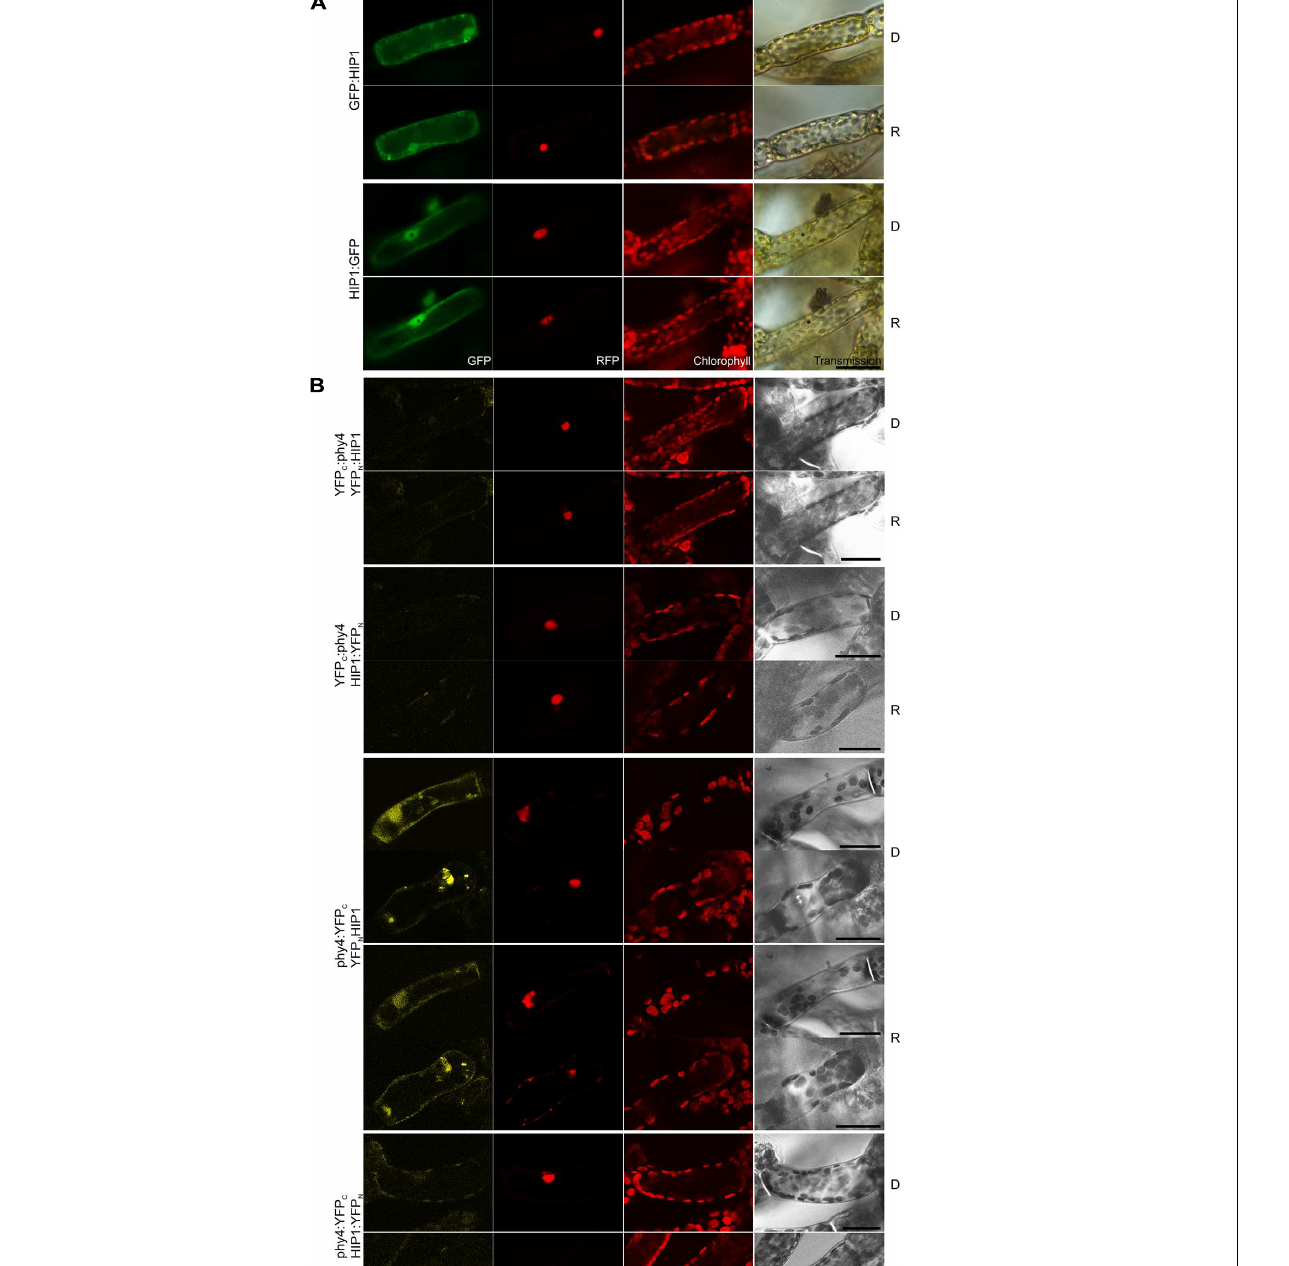
Frontiers in Plant Science |